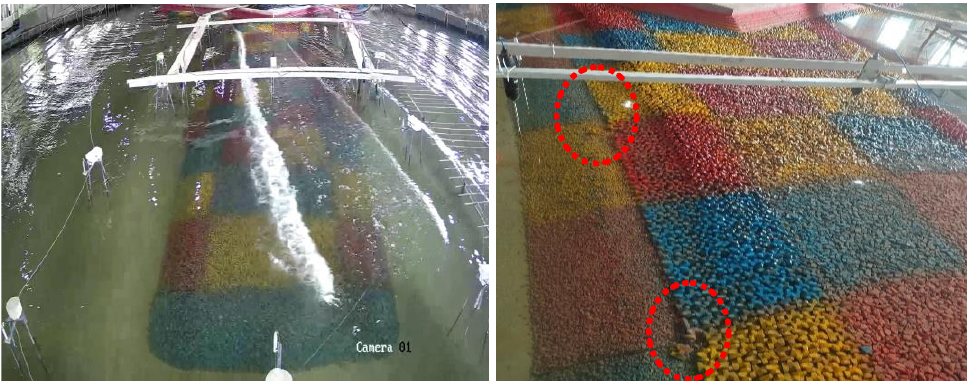
Figure 7. Wave state and stability after wave – current coupling. Table 3. Revision of design wave height cumulative frequency standard.